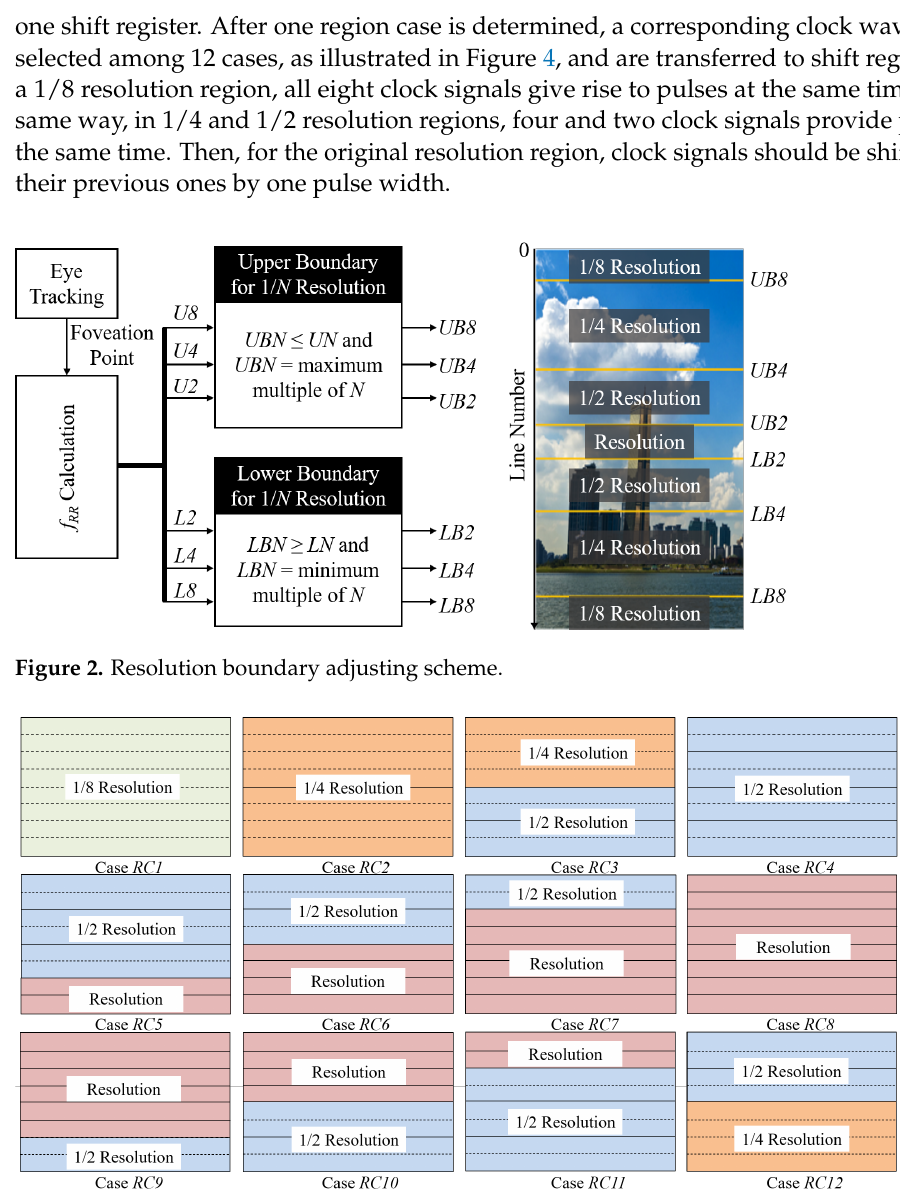
Figure 3. Twelve possible resolution cases for the region of an eight-output shift register. On the other hand, as the foveation point moves, the effective number of lines in the reduced resolution image also changes. It has the maximum value for the foveation point in the center of a panel, while it gets to be the minimum for the foveation point in the uppermost and lowermost positions of a panel. To support fixed frame and line times even at this variable effective number of lines, the variation on the vertical blank length, which is recently used to support the variable frame rate in gaming and low power display applications [24,25], maintains the total number of vertical lines including vertical active and blank areas at the constant number. For example, when the effect numbers of lines at the center and uppermost positions are 1456 and 928 for the vertical resolution of 4800 lines [14], the vertical blank lengths are set to be 14 and 542, respectively. Consequently, this vertical blank adjustment leads to the constant total number of vertical lines of 1470 for any foveation points. Unlike the variable frame rate applications, this vertical blank variation scheme causes no flicker problems because the frame rate is maintained at the fixed value